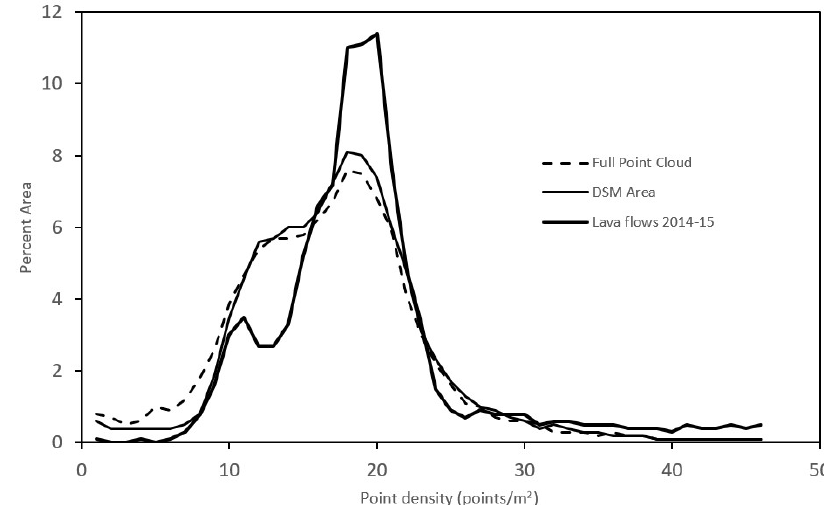
Figure 10. Point density frequencies in selected areas of the Chã das Caldeiras point cloud.